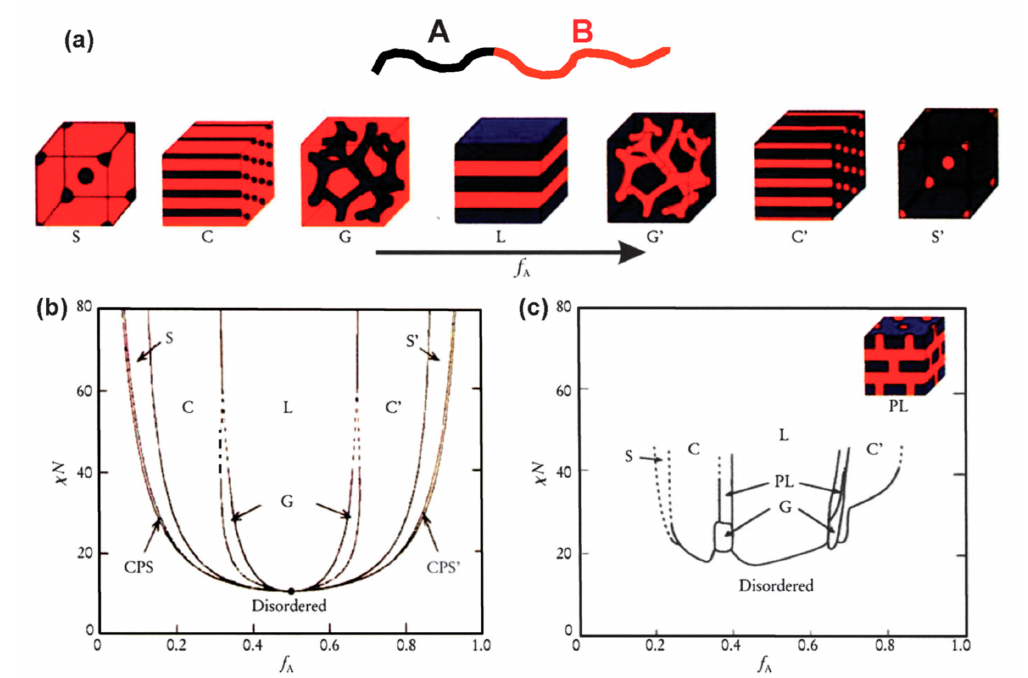
Figure 2. ( a ) Equilibrium morphologies of AB diblock copolymers in bulk: S and S’ = body-centered cubic spheres, C and C’ = hexagonally packed cylinders, G and G’ = bicontinuous gyroids, and L = lamellae. ( b ) Theoretical phase diagram of AB diblocks predicted by the self-consistent mean-field theory, depending on volume fraction ( f ) of the blocks and the segregation parameter, χ N ; CPS and CPS’ = closely packed spheres. ( c ) Experimental phase diagram of polystyrene- b -polyisoprene copolymers, in which f A represents the volume fraction of polyisoprene, PL = perforated lamellae. (Reproduced with permission from [28], Copyright Royal Society of Chemistry).